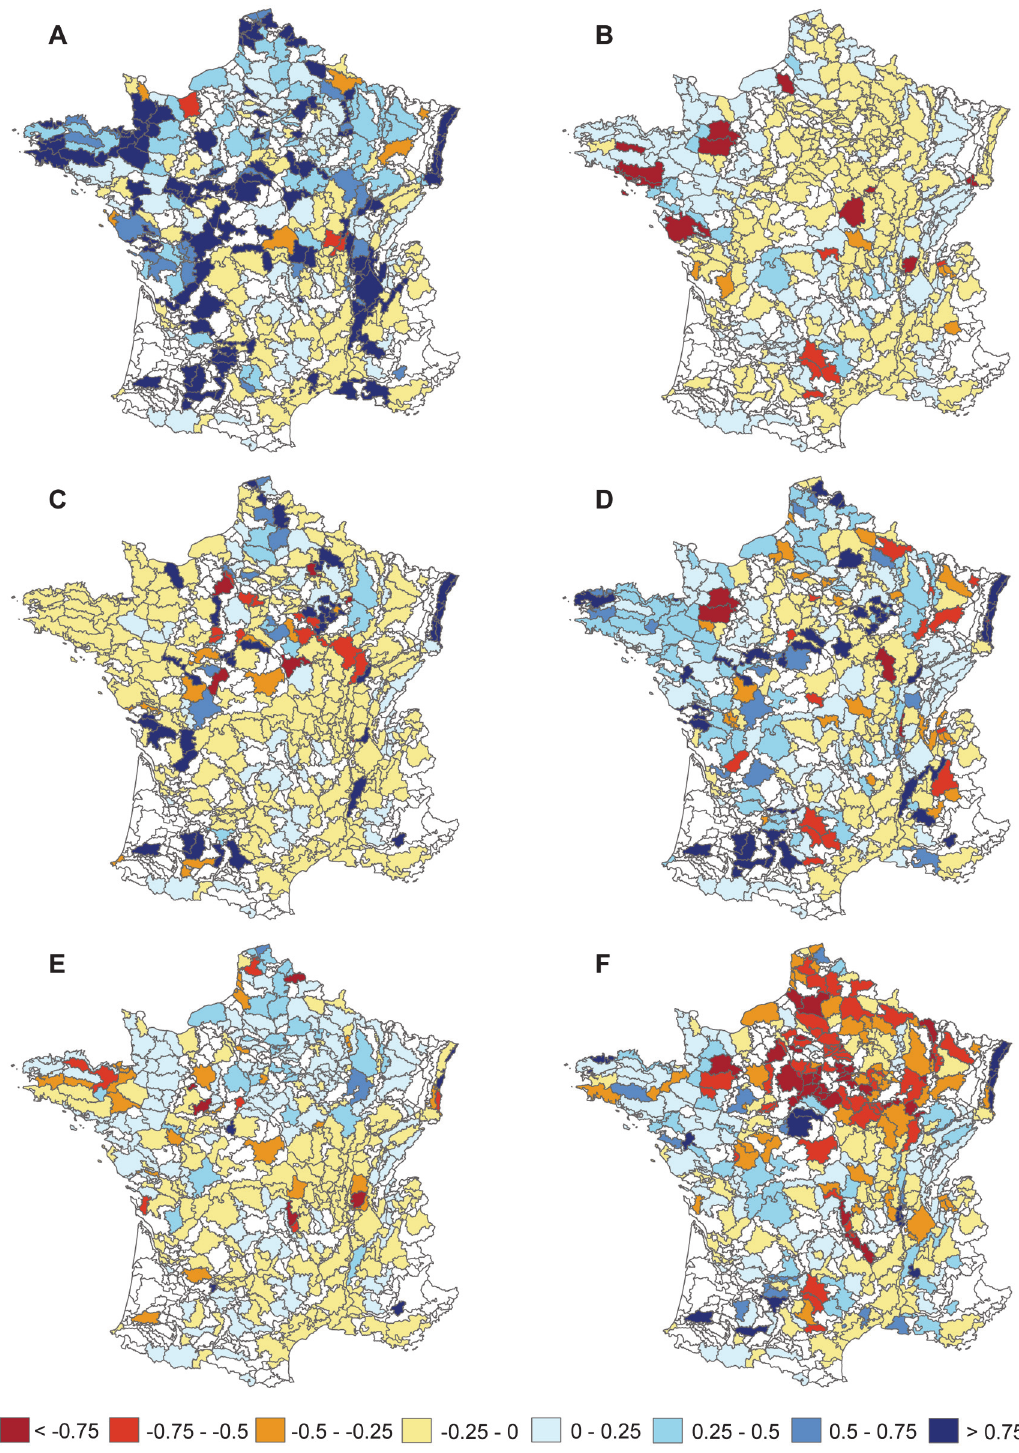
Fig 4. Predicted regional responses of Skylark Alauda arvensis to the different scenarios. Percent change in regional abundance of Skylark (one of the cropland specialist species) in response to the different land cover scenarios: A) ‘ status quo ’ , B) ‘ livestock extensification ’ , C) ‘ global biofuel ’ , D) ‘ regional biofuel ’ , E) ‘ global extensification ’ and F) ‘ regional extensification ’ , all combined to climate and land use change scenarios. The more red it is the more abundance decreases.